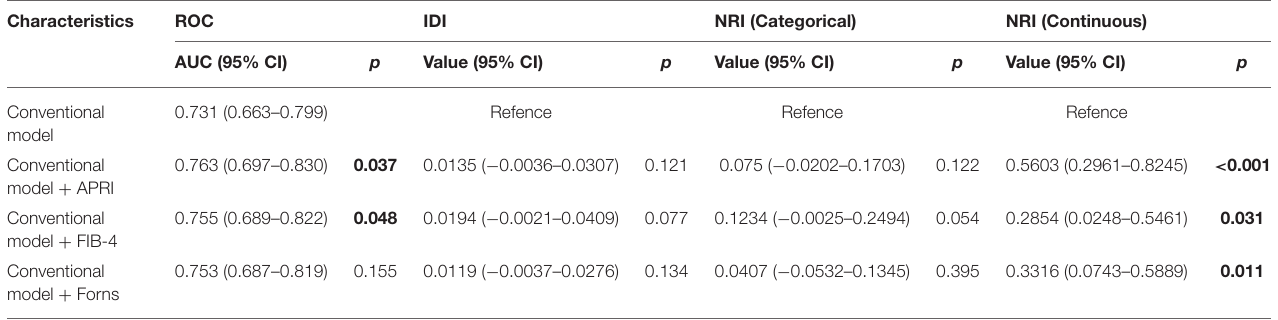
TABLE 5 | Incremental predictive value of liver fibrosis scores for predicting recurrence in patients with CSDH.